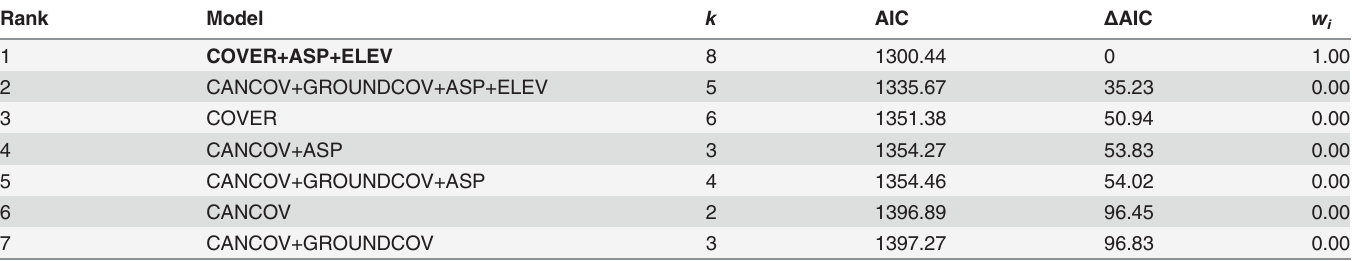
Included are the number of estimated parameters ( k ), Akaike ’ s information criterion (AIC), Akaike ’ s information criterion differences ( Δ AIC), and Akaike weights ( w i ). Models retained for statistical inference are in bold.